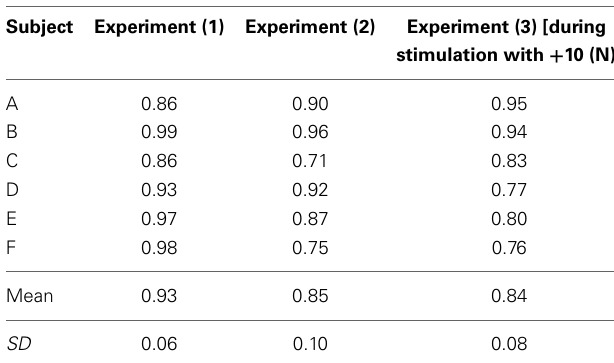
Table 3 | Multiple coefficients of